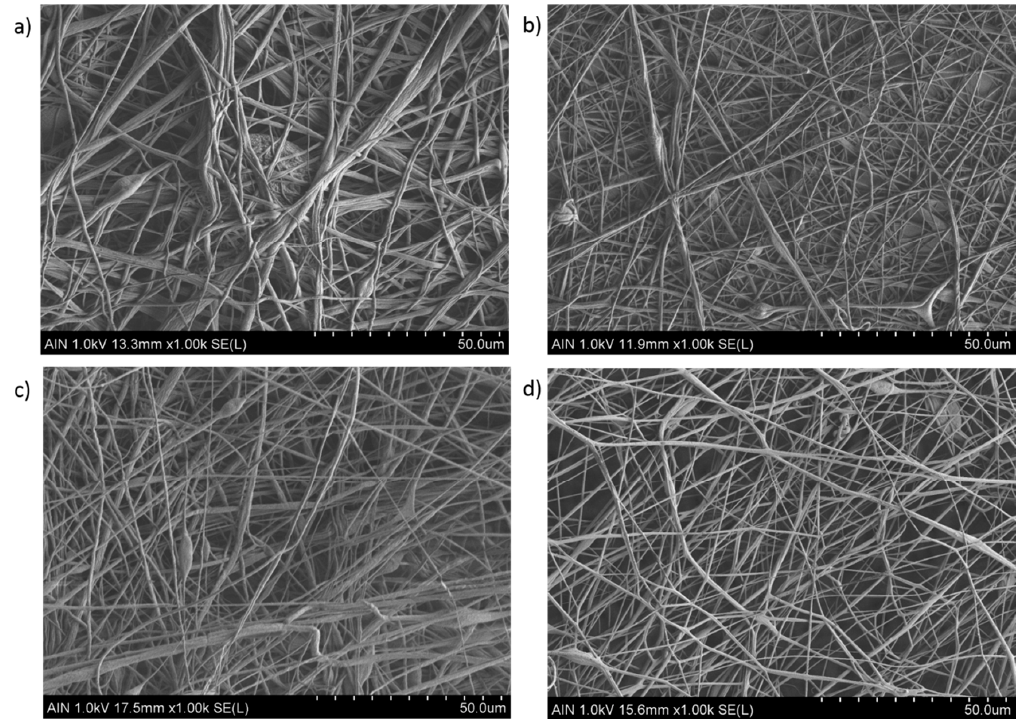
Figure 2. Scanning electron microscopy (SEM) images representing the surface morphologies of the electrospun mats for Sample 1 ( a ), Sample 2 ( b ), Sample 3 ( c ), and Sample 4 ( d ). The scale bar is 50 µm in all images.